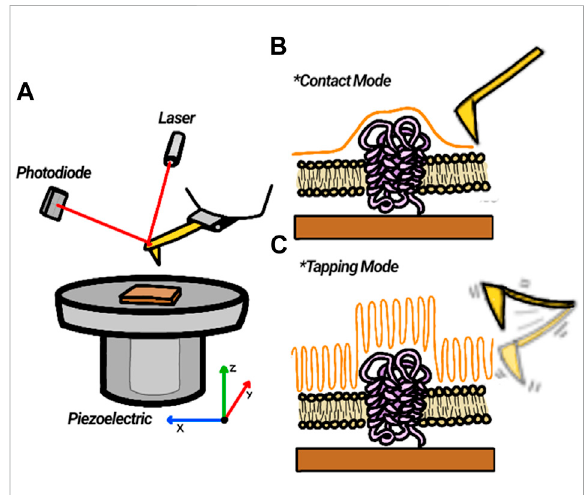
Description of AFM principle. (A) A laser re fl ected from the back of a cantilever impinges on a photodiode and reports on the vertical displacement of the tip as it scans the Surface. (B) In contact mode, the tip touches the sample and de fl ects vertically following surface topography. (C) In tapping mode, a tip oscillating at or near its resonant frequency scans over the surface while maintaining its amplitude constant. The piezo vertical displacements re fl ect the surface